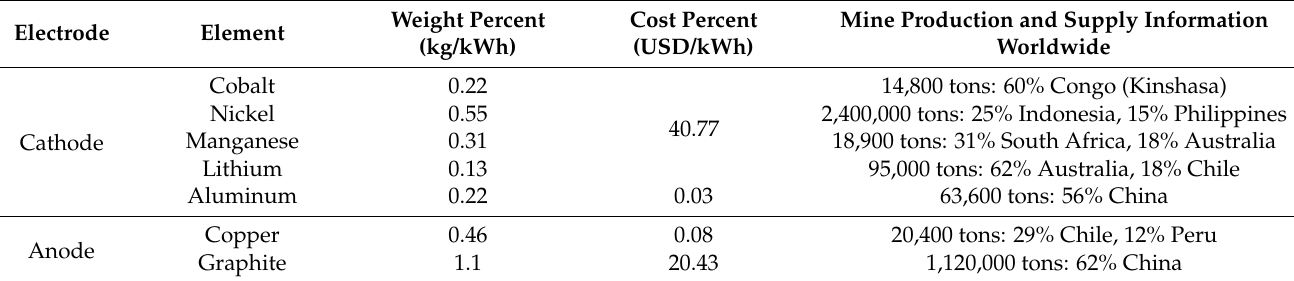
Table 1. Summary of 60 kWh NMC532/graphite battery materials